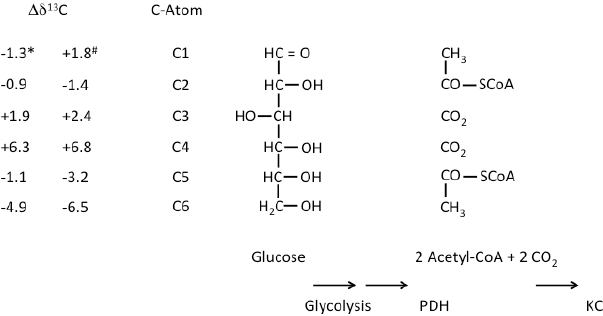
Fig. 6. Relative intramolecular 13 C distribution for different carbon positions calculated as deviation from the mean δ 13 C of the whole molecule. Examples are given for glucose (*), determined by step- wise fermentation by Rossmann et al. (1991) and for the glucose moiety of sucrose (#) determined by NMR by Gilbert et al. (2009). Glucose enters glycolysis where two CO 2 molecules from the C- 3 and C-4 positions are decarboxylated by pyruvatedehydrogenase (PDH) and the remaining 13 C-depleted Acetyl-CoA molecules en- ter the Krebs cycle (KC).